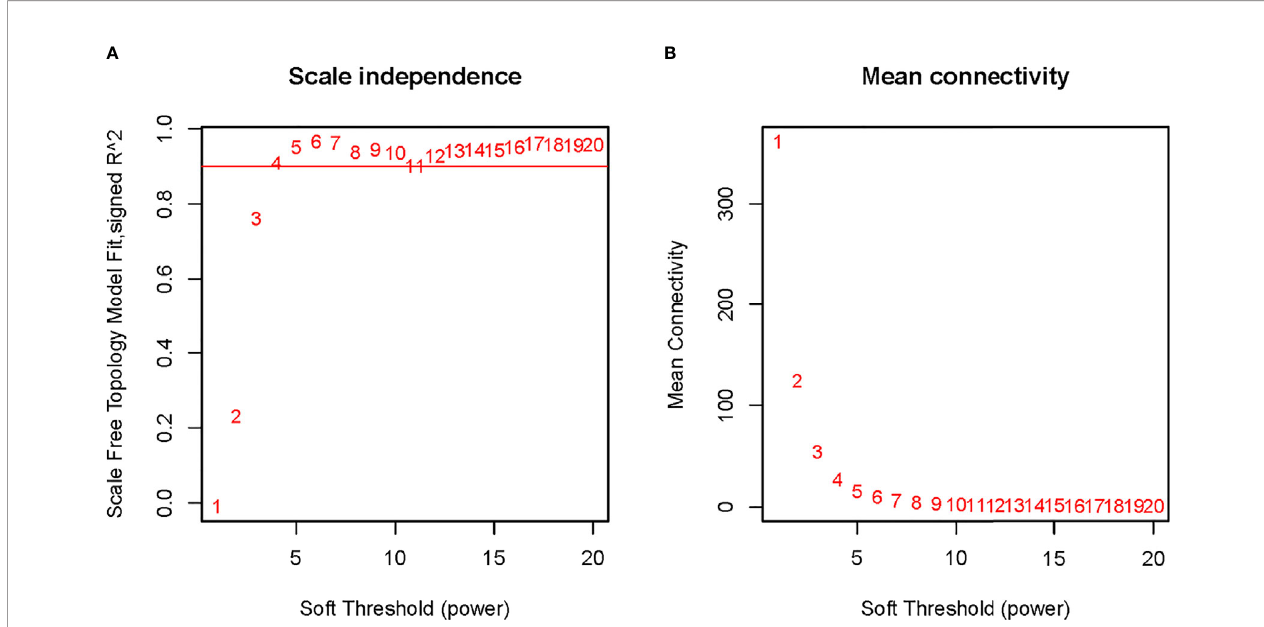
FIGURE 2 | Determination of soft-thresholding power in weighted gene co-expression network analysis (WGCNA). (A) The scale-free fi t index for various soft- thresholding powers; (B) The mean connectivity for various soft-thresholding